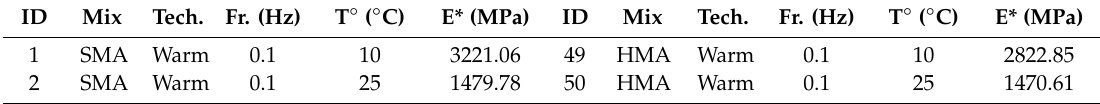
Table A1. The instances used in this